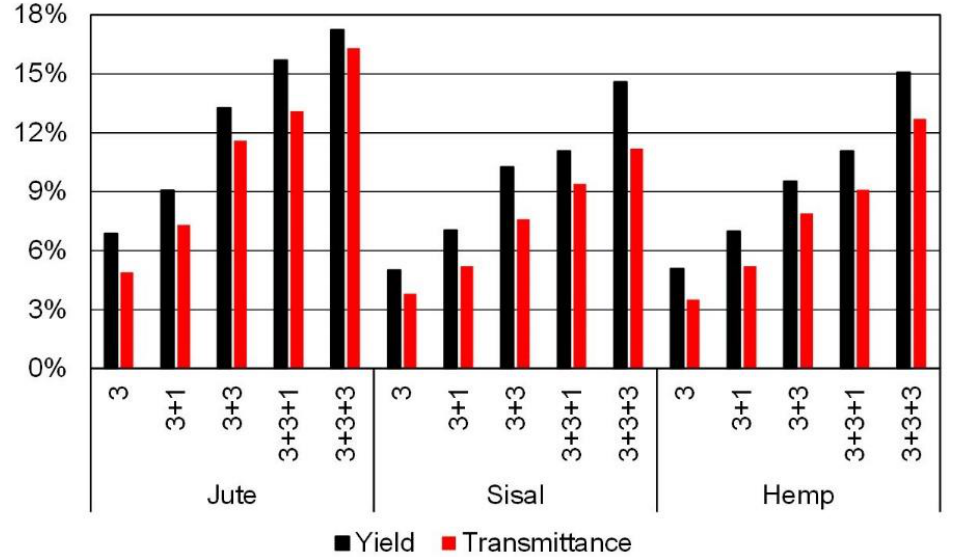
Figure 4. Yield of nanofibrillation and transmittance at 600 nm for jute, sisal and hemp MNCF after extensive PFI refining and different numbers of HPH cycles.